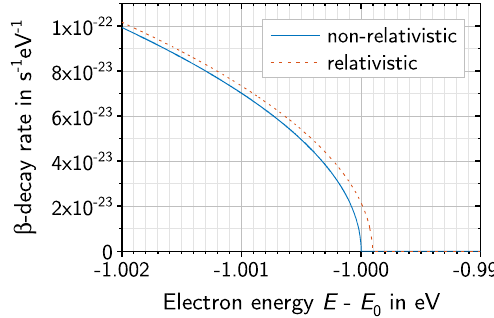
Fig. 4 Comparison of the differential β -electron energy spectrum of atomic tritium for the full relativistic kinematic treatment and the non- relativistic approximation, assuming a neutrino mass of m ν = 1 eV